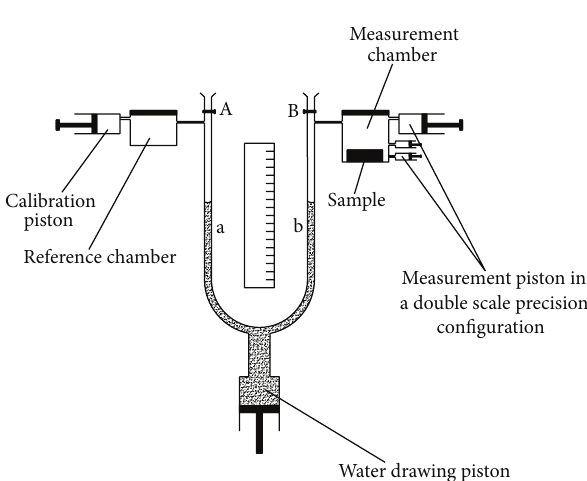
Figure 4: The layout for the test equipment for